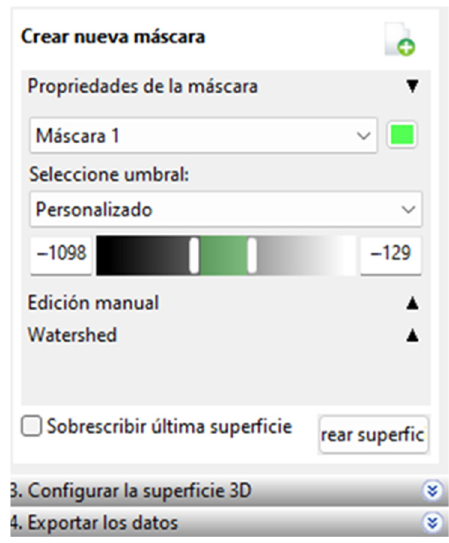
Figure 3. Range of selected values.